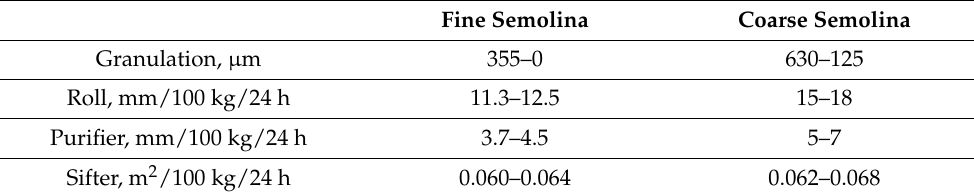
Table 5. Milling surface allocation of durum semolina mills for fine and coarse semolina 1